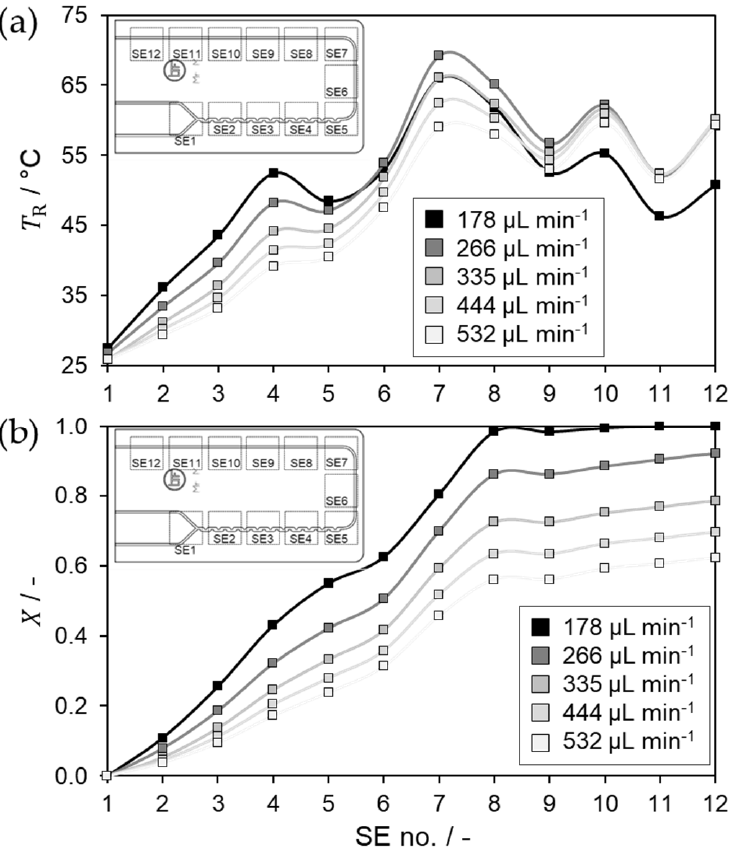
Figure 5. ( a ) Modelled temperature profile for sodium thiosulfate oxidation using hydrogen peroxide in LTF-MS obtained in steady state; ( b ) Corresponding modelled conversion profile.